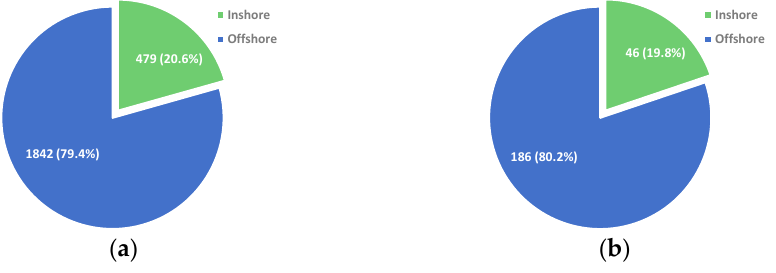
Figure 18. The proportion of inshore and offshore scenes in the test sets of ( a ) RSSD and ( b ) SSDD. Furthermore, a public benchmark for OBB-based ship detection in optical remote sensing images, the HRSC2016 dataset [66], is used to verify the generalization ability of the proposed method across different scenarios. It contains 1061 high-resolution aerial images, including 2976 different types of ships annotated by oriented bounding boxes, with the image size ranging from 300 × 300 to 1500 × 900 pixels. We employ the training (436 images) and validation (181 images) sets for training, and the test set (444 images) for testing. All images are resized to 800 × 512 pixels without altering the original aspect ratio. The experiments are conducted on the platform with Ubuntu 18.04 OS, 32 GB of RAM, and a NVIDIA GTX 1080Ti GPU. For all datasets, we train the models in 72 epochs. The SGD optimizer is adopted with a batch size of 2 and an initial learning rate of 0.0025. The momentum and weight decay are 0.9 and 0.0001, respectively. As for the learning schedule, we apply the warmup strategy for 500 iterations, and the learning rate is dropped 10-fold at each decay step. If not specified, ResNet50 [57] is employed as the default backbone network. Its parameters are initialized by ImageNet pretrained weights. For fair comparisons with other methods and to avoid over-fitting, we only use random flipping and rotation for data augmentation in the training phase. If not specified, no extra tricks are